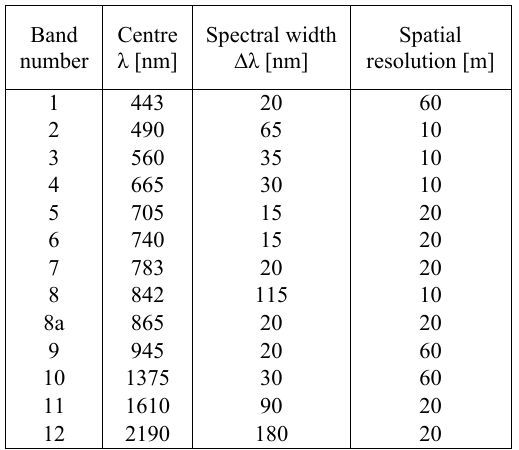
Table 2. Multi-spectral instrument specifications.